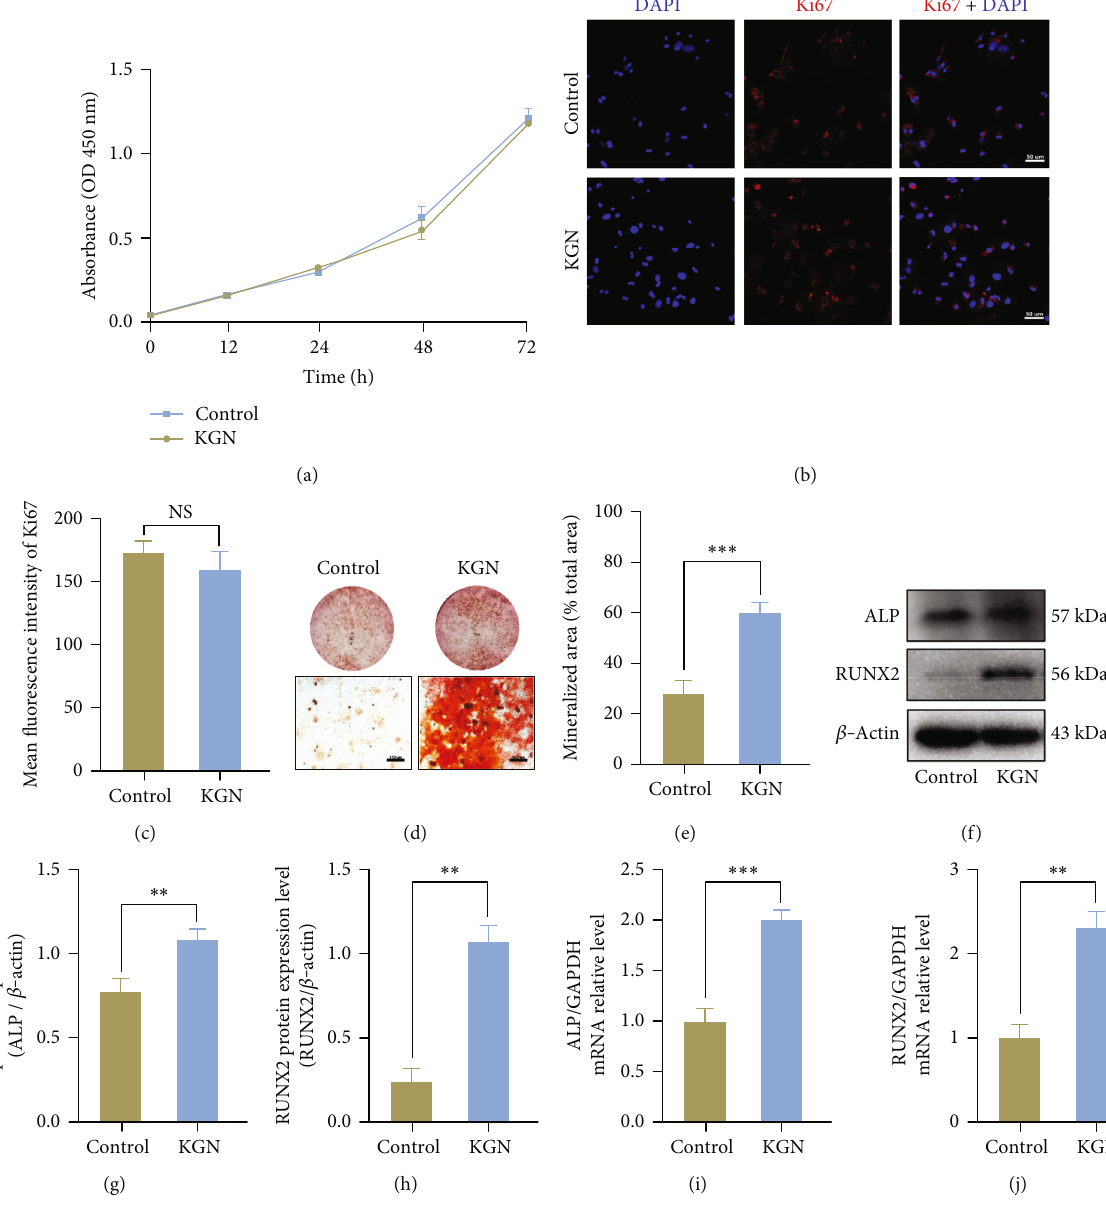
Figure 1: KGN enhances the osteogenic ability of BMMSCs without a ff ecting cell proliferation. Cell proliferation capacity of BMMSCs was measured by CCK-8 (a), immuno fl uorescent staining (b) of Ki67, and semiquanti fi cation (c) of (b) between the control and KGN-treated BMMSCs. p > 0 : 05 , independent Student ’ s t test. ARS staining detection (d) and semiquanti fi cation (e) of mineralized nodules. KGN promoted osteogenesis of BMMSCs. Scale bar = 500 μ m. ∗∗∗ p < 0 : 001 , independent Student ’ s t test. Western blotting (f) and semiquanti fi cation analysis (g, h) and qRT-PCR (i, j) of osteogenic markers ALP and Runx2. KGN upregulated the expression of osteogenic genes. ∗∗ p < 0 : 01 and ∗∗∗ p < 0 : 001 , independent Student ’ s t